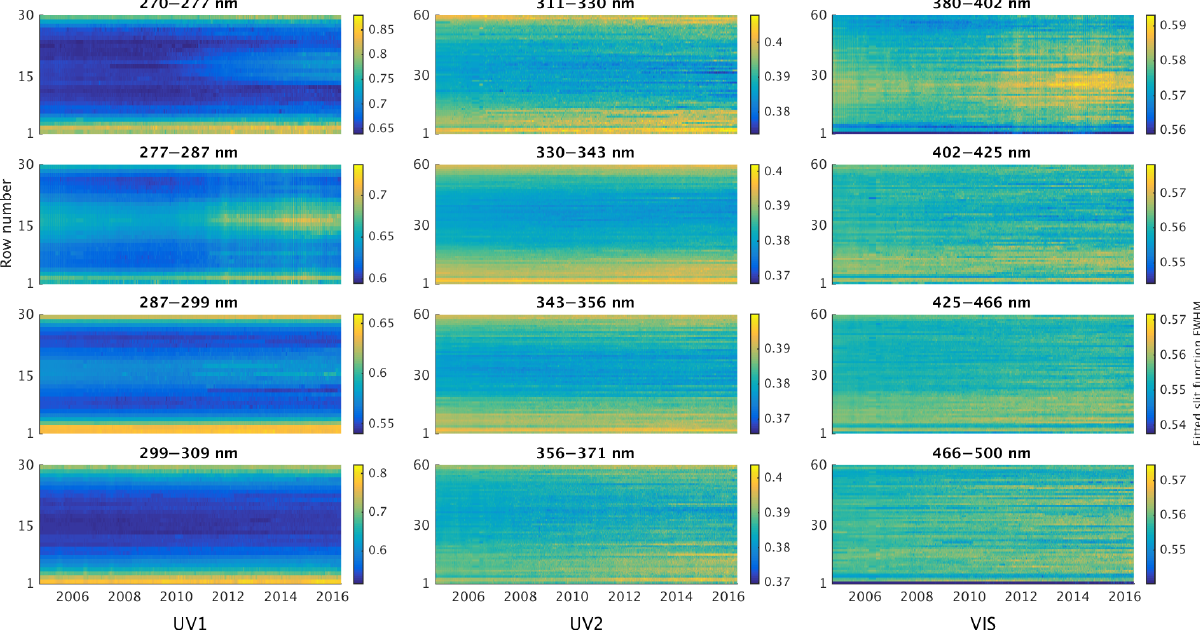
Figure 4. Temporal variations of derived standard Gaussian slit function FWHM for all cross-track positions from September 2004 to May 2016. Three OMI bands (columns of the plot) are each divided into four fitting windows (rows of the plot). Spectral coverages of each window are also labeled in the title of each